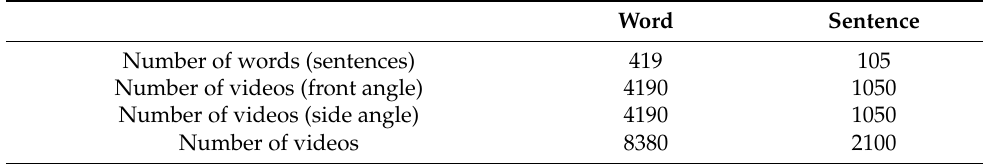
Table 1. Number of words and sentences in the KETI sign language dataset.